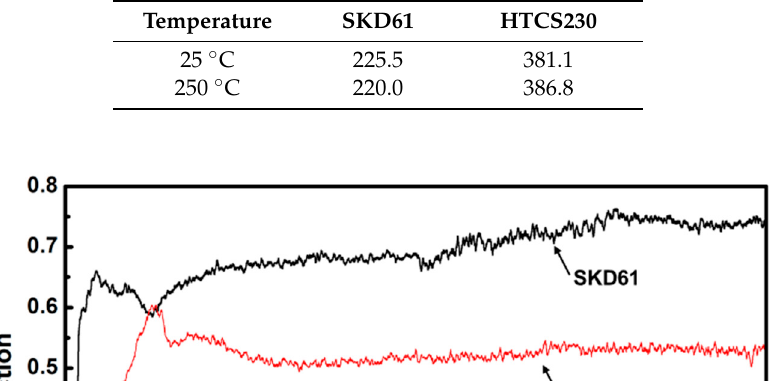
Figure 12. Friction coefficients of die materials at 250 °C.